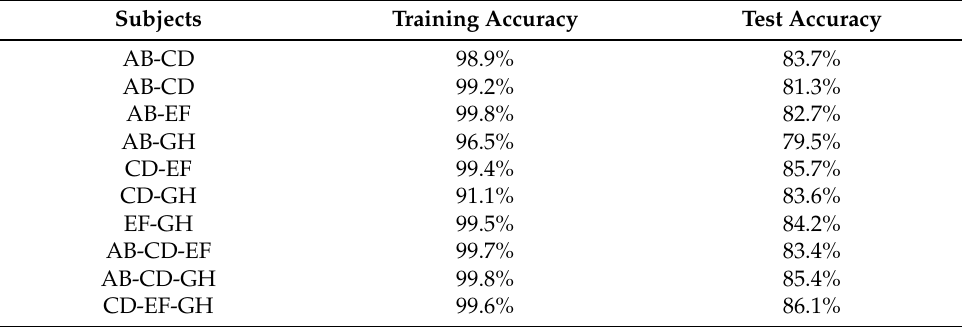
Table 6. Classification accuracy of subject combinations.